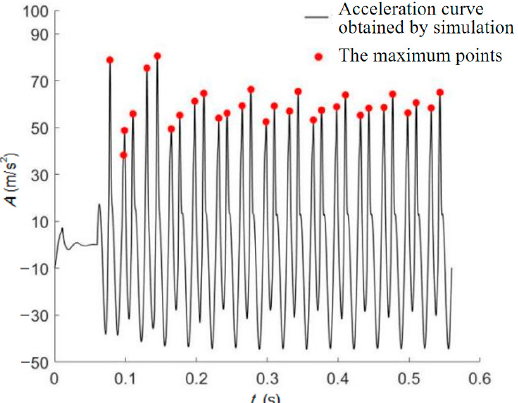
the steel wheel acceleration signal, the system simulation parameters were set as E = 1300